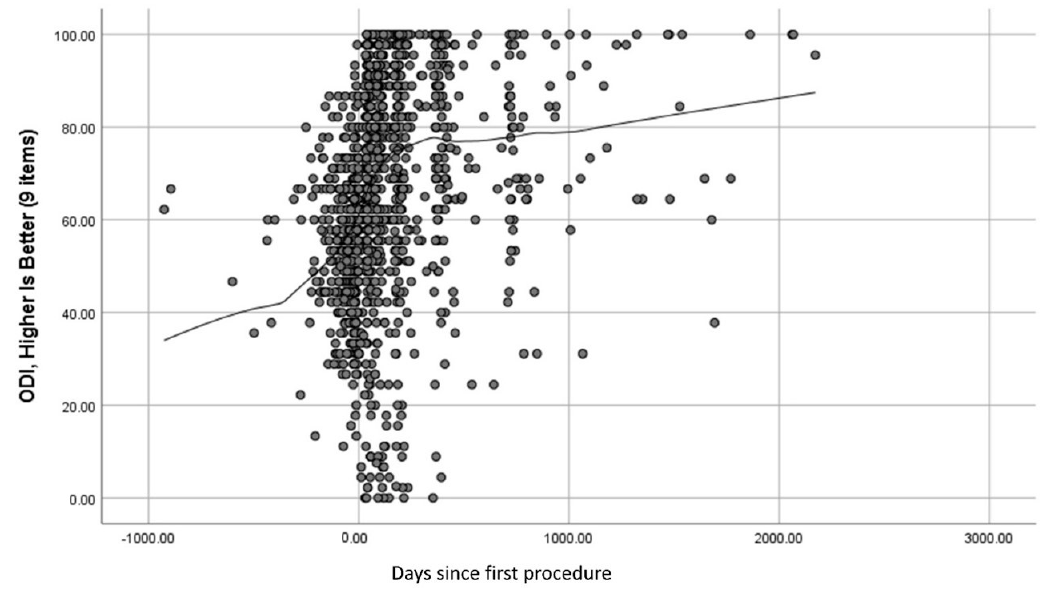
Figure 1. Scatter Plot of ODI Scores Over Time .